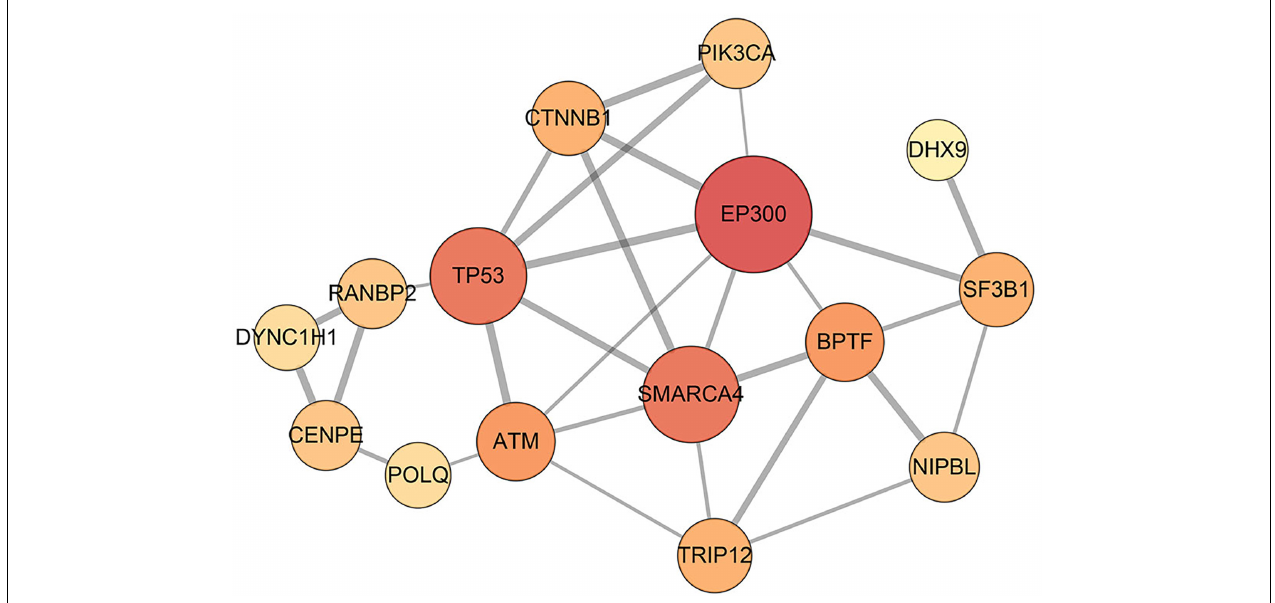
FIGURE 2 | Interaction network of disease-related genes. In total, 29 interactions among 15 disease-related genes are identified by STRING database, and they can be considered as a disease module. The edge with a higher combined score from the STRING database is wider, and the node with the higher degree is bigger.